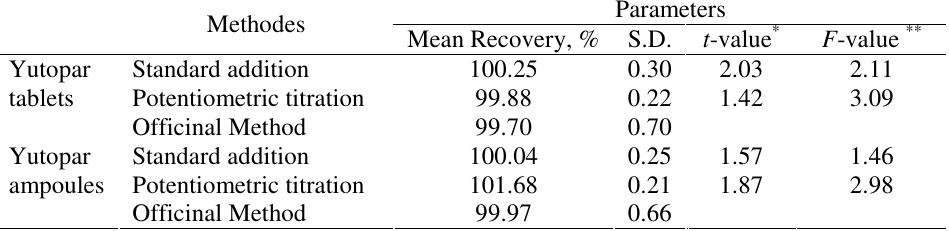
Table 7. Statistical analysis of the results obtained for the determination of ritodrine HCl using RTH-selective in comparison with officinal